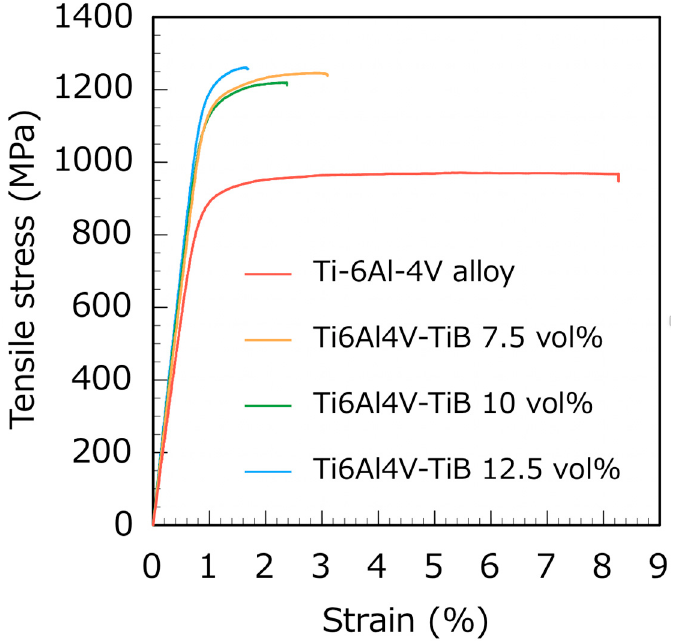
Figure 5. Typical stress-strain curves of Ti6Al4V-TiB composites.